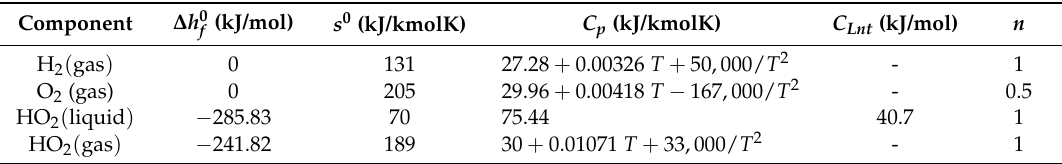
Table A1. Thermodynamic properties used to quantify energy demand of electrolysis [39,40]. Component